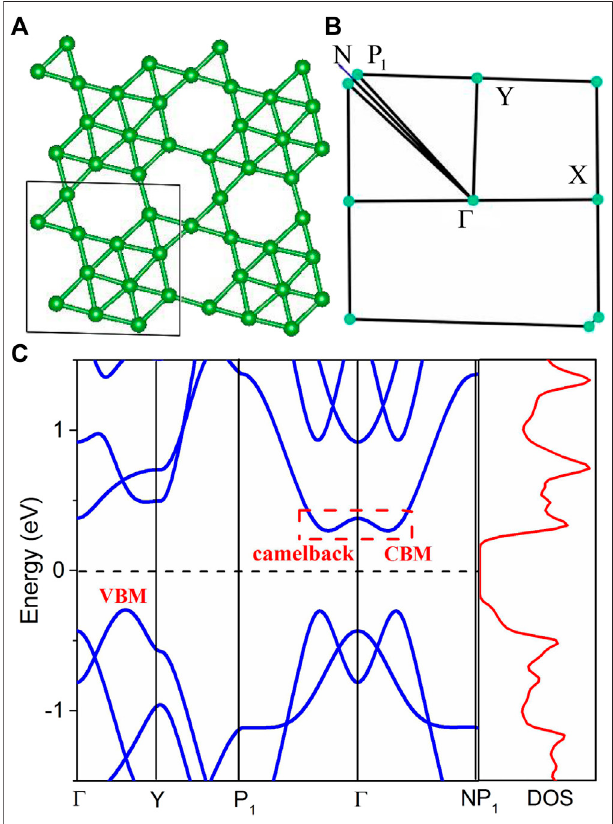
FIGURE 1 | The atomic structure (A) and the Brillouin zone path (B) of the β s 1 boron monolayer and (C) shows the calculated band structure and density of